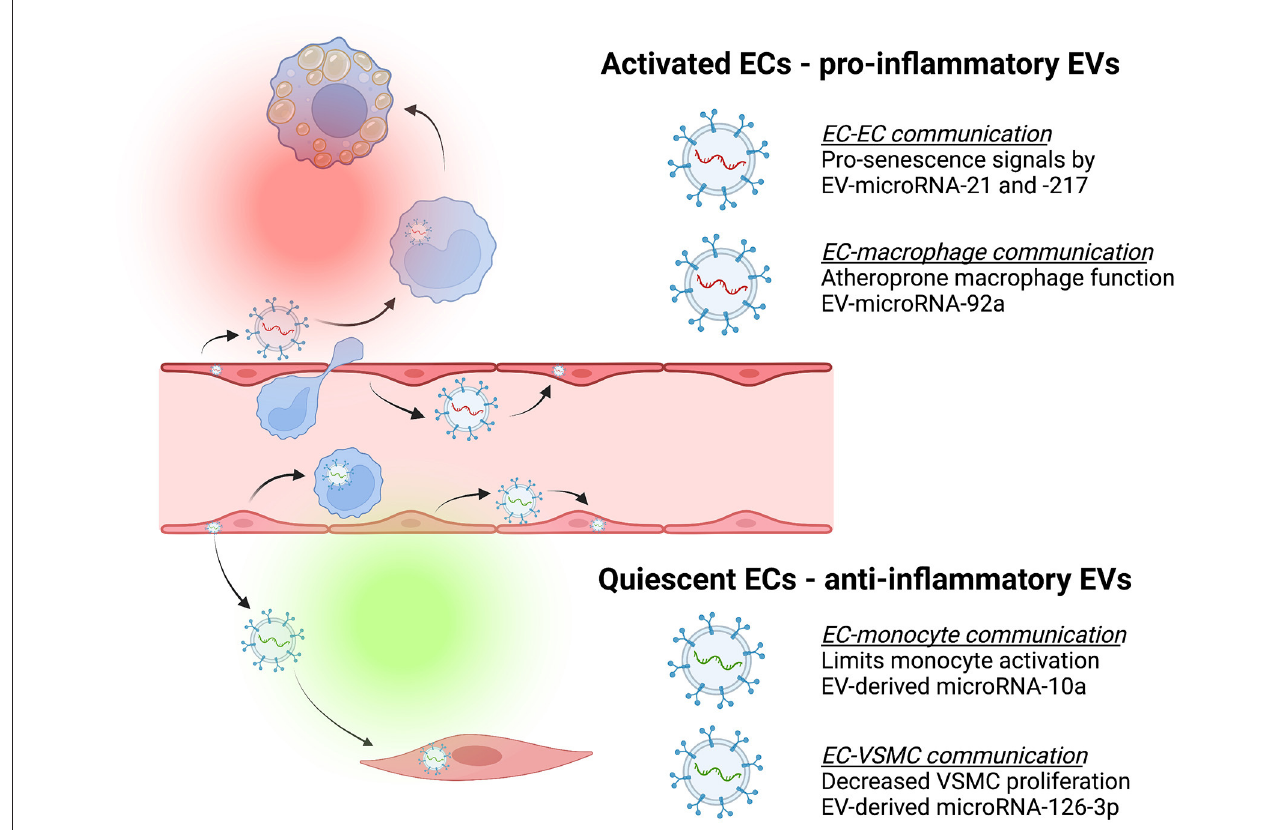
FIGURE 2 | Endothelial-derived extracellular vesicles (EVs) contribute to cell-cell communication that can be atheroprotective (green) or atheroprone (red). Endothelial cells (ECs) release EVs containing different cargo depending on whether they are activated or quiescent, and these have effects on recipient cells [e.g., monocytes, macrophages, and vascular smooth muscle cells (VSMC)]. For example, activated ECs release EVs that deliver pro-senescence signals such as microRNA-21 and microRNA-217 to other ECs ( 78) or separately, release EVs containing microRNA-92a capable of inducing macrophage inflammation and impaired migration (48). In contrast, quiescent ECs release EVs containing cargo such as microRNA-10a that limit monocyte activation (45) or EVs containing microRNA-126-3p to decrease VSMC proliferation and neointima formation